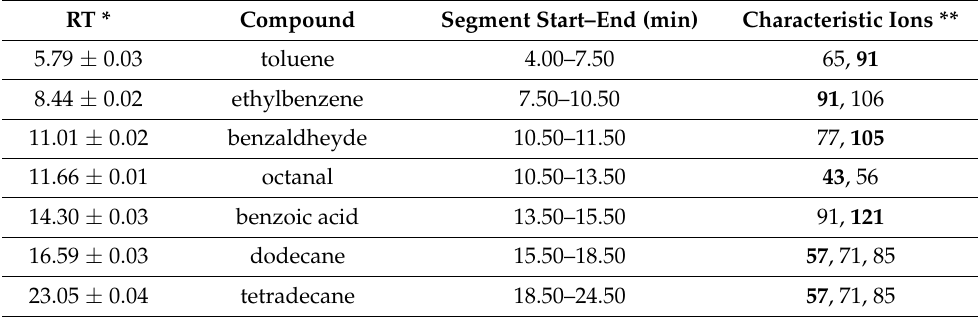
Table 1. SIM operation mode